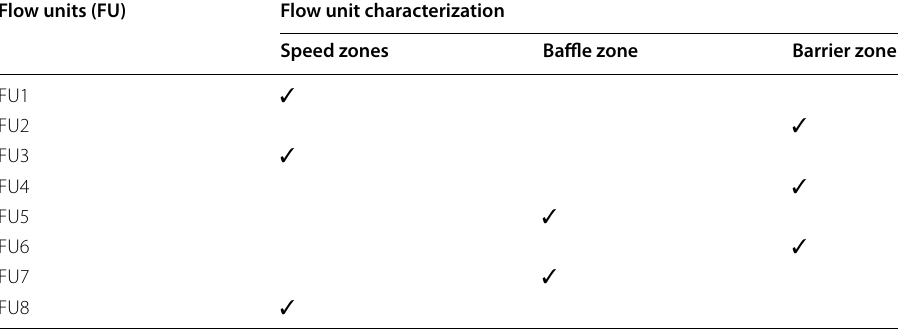
Table 3 Aquifer flow unit characterization Flow units